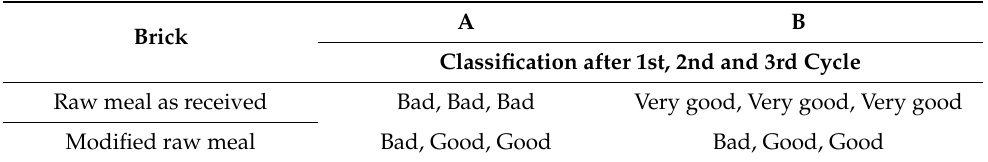
Table 4. Evaluation of contact coating test for the bricks A and B.